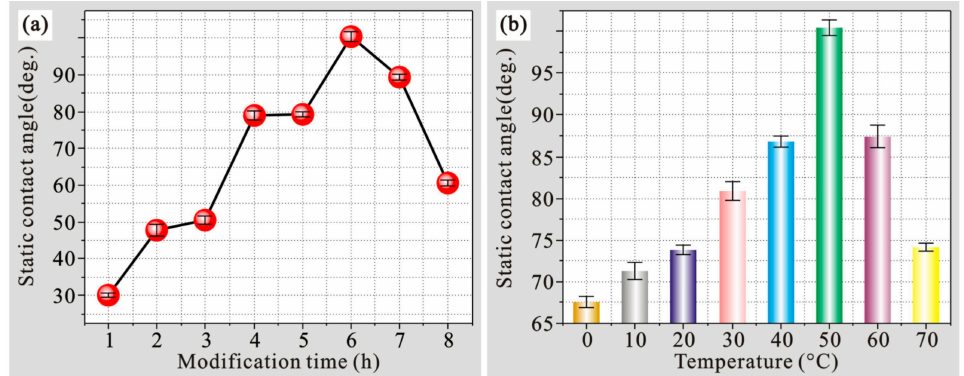
Figure 6. ( a ) Optimization of fluor silane modification time on aluminum alloy surface and ( b ) opti- mization of fluor silane drying temperature on the aluminum alloy surface.